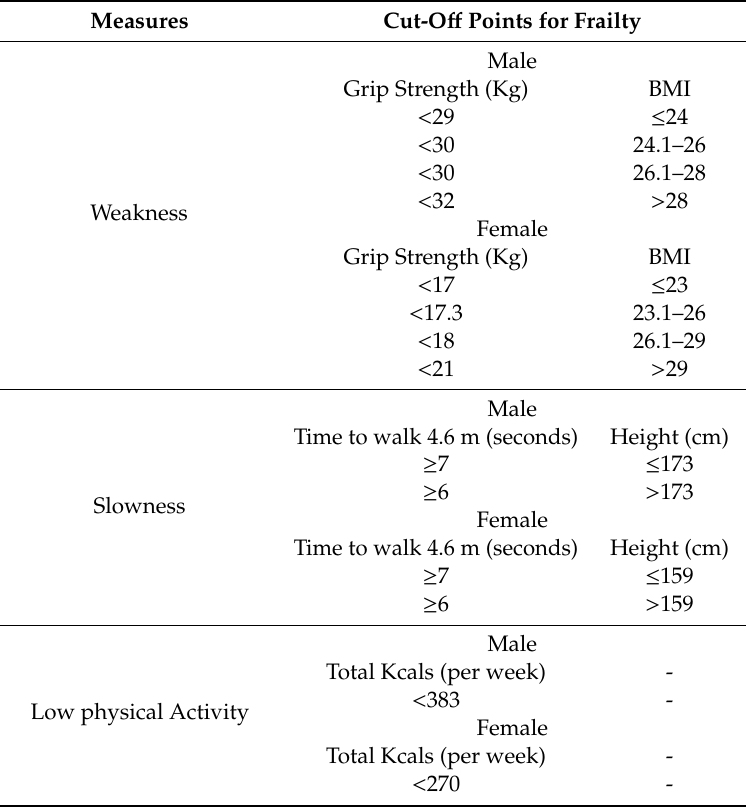
Table A1. Cut-o ff points for frailty